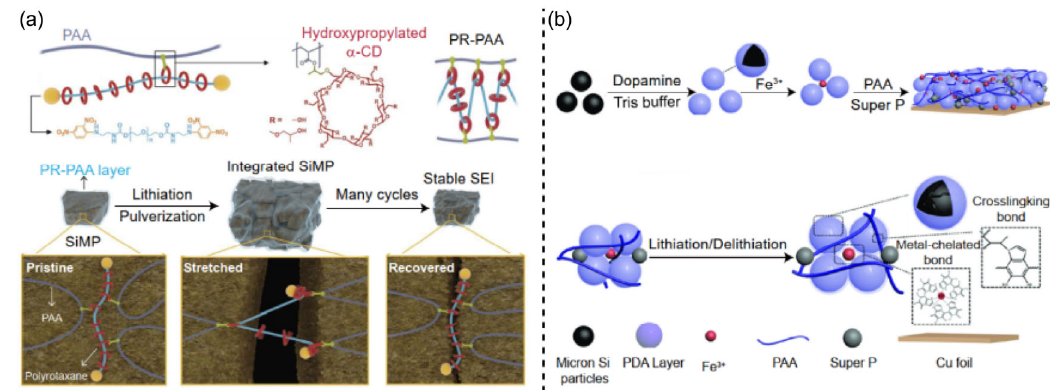
Figure 9 (a) Proposed stress dissipation mechanism of PR-PAA binder for SiMP anodes. Reproduced with permission from Ref. [145], © American Association for the Advancement of Science 2022. (b) Graphical illustrations of the synthesis process of Si@Fe 3+ –PDA/PAA anode and suppression of Fe 3+ –PDA/PAA